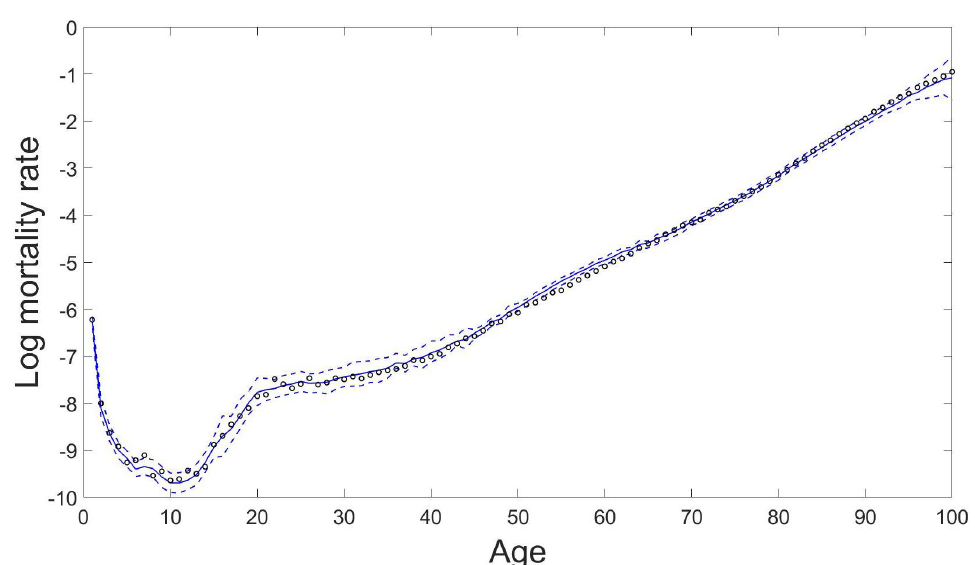
Figure 4. Predicted male mortality curve from age 0 to age 100 with the 95% prediction intervals using the proposed GPR model for the year 2016 based on the observations from the year 1947 to the year 2006 in Japan. The circles are the true log mortality rates, the solid line is the prediction, and the dashed lines are the 95% prediction